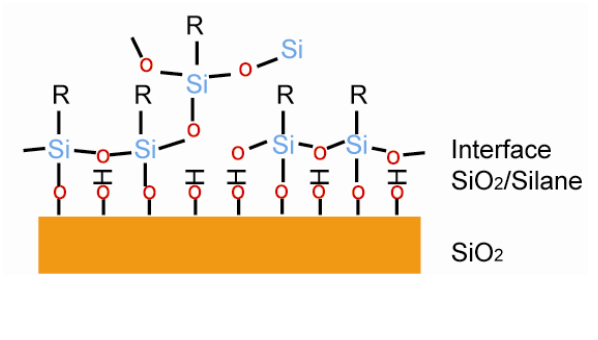
Figure 8. Structure of organosilane based layer. Organosilane SAM is connected to hydroxylated silicon dioxide surface through S–O bond. Some organosilane molecules were connected to the neighboring molecules (adapted from